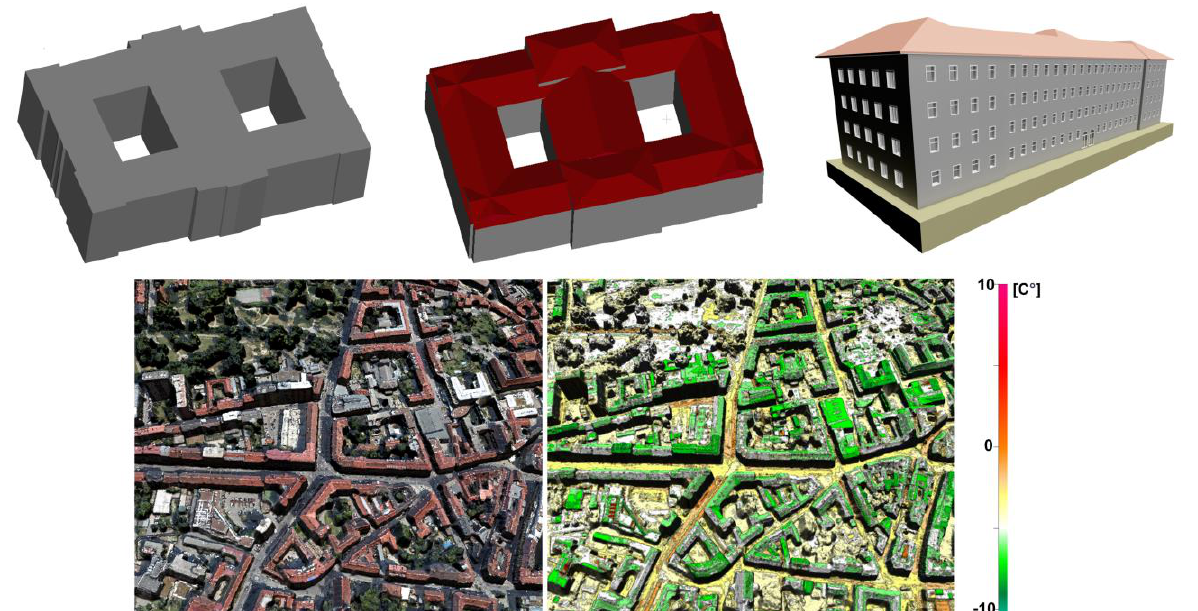
Figure 6. Building models of Trento at various levels of details (top). 3D mesh model of Graz textured with RGB and thermal orthoimages (bottom).